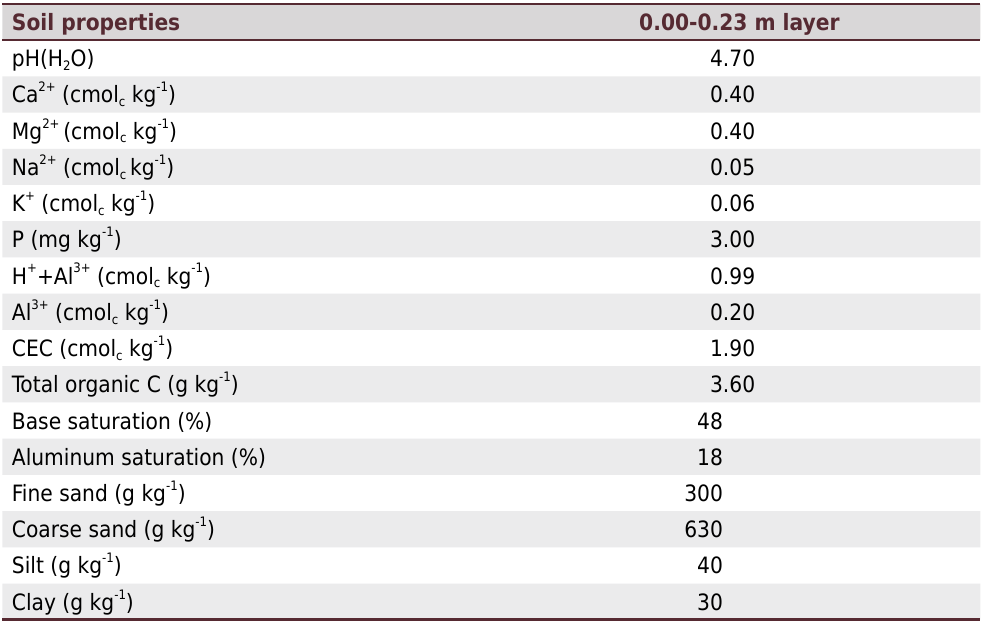
Table 1. Selected soil physical and chemical properties of an Arenic Kandiustults cultivated with early dwarf cashew in the experimental station in the municipality of Pacajus, Ceará, Brazil Soil